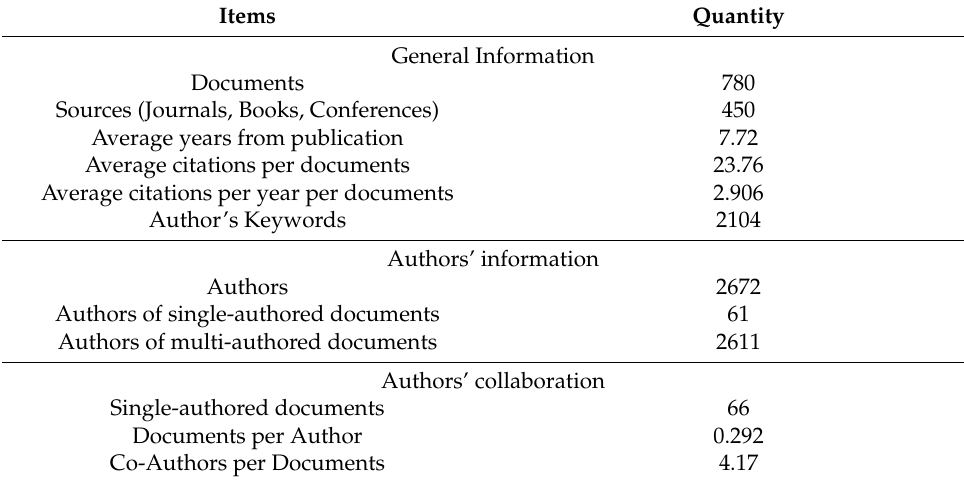
Table 1. General information based on the two bases merger.